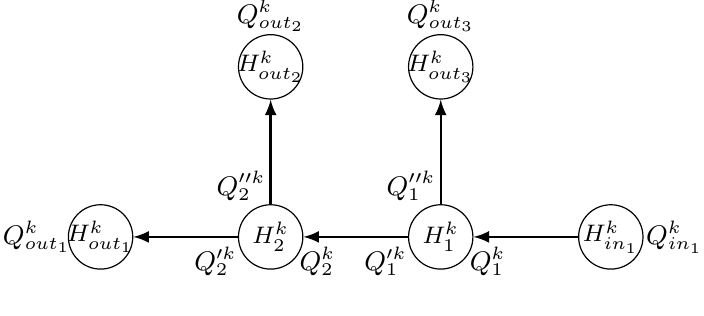
Figure 10. Branched pipeline